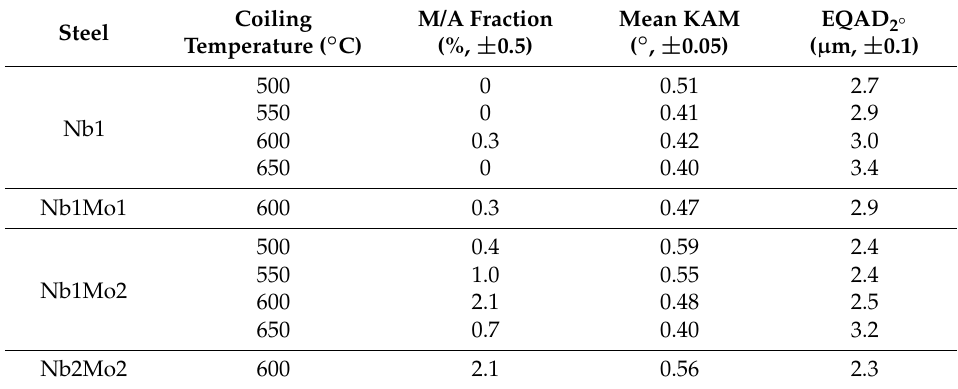
Table 4. Microstructure features in coiling simulated samples as determined by EBSD analysis.